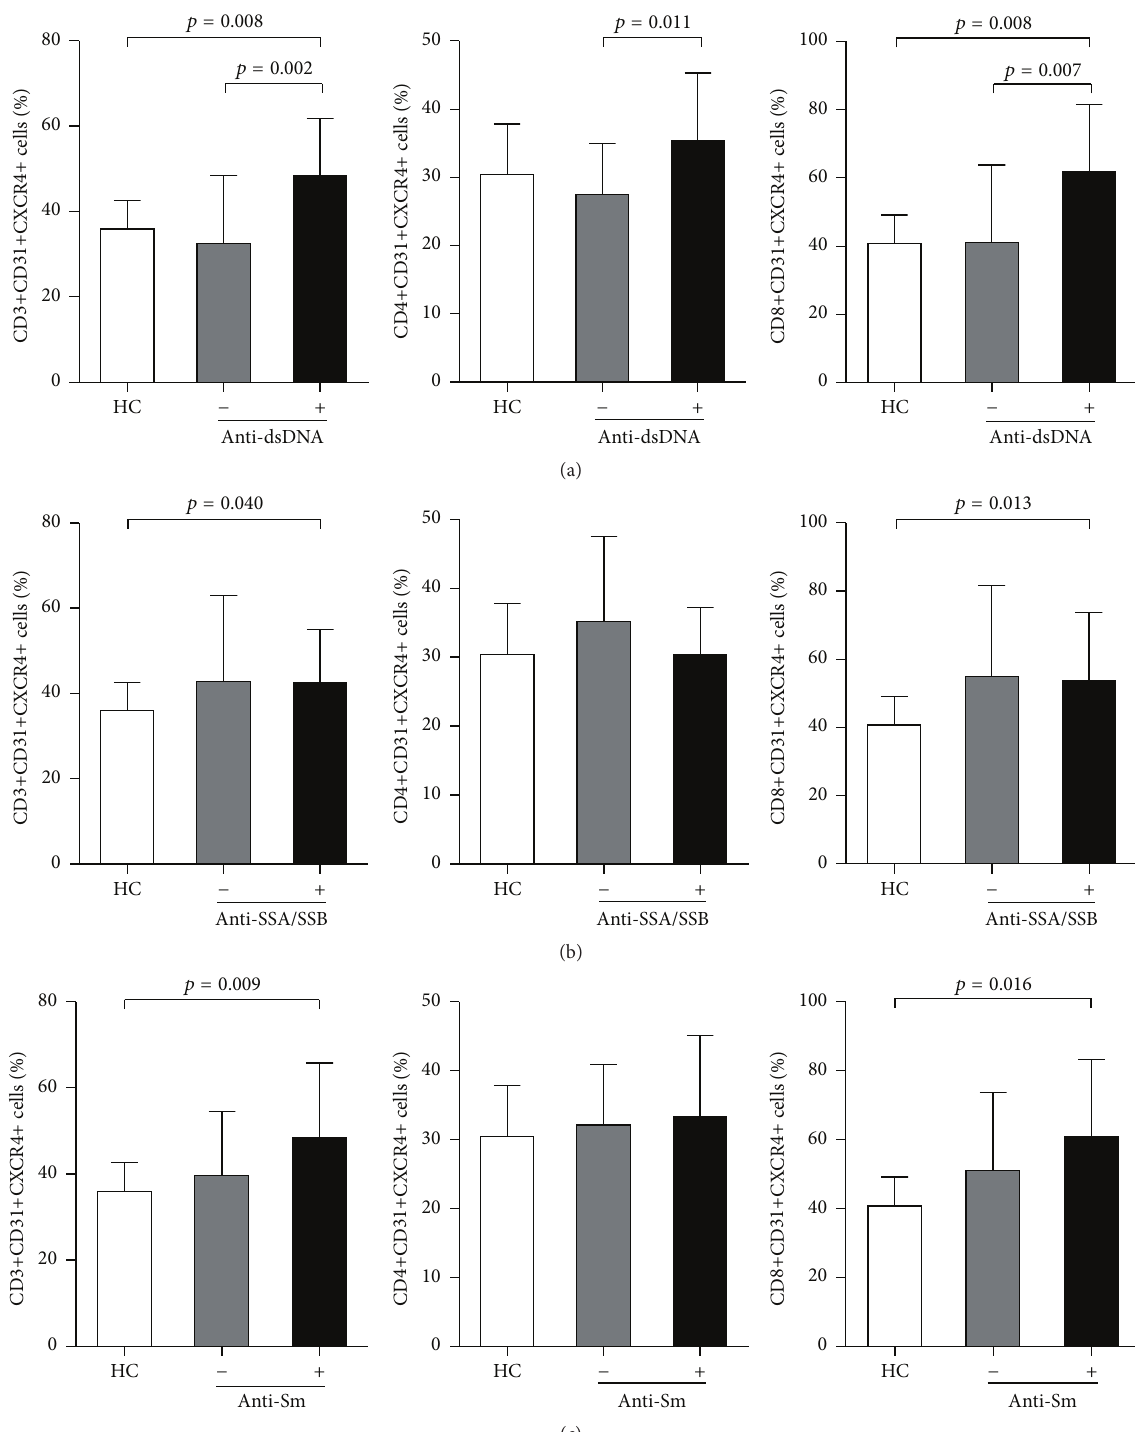
Figure 2: Association between Tang cell subsets and autoantibody status. Percentages of circulating Tang cell subsets (including CD31+CXCR4+ cells in CD3+, CD4+, and CD8+ T cells) in SLE patients with or without anti-dsDNA autoantibodies (a), anti-SSA/SSB autoantibodies (b), and anti-Sm autoantibodies (c). 𝑝 values were assessed by Mann-Whitney U